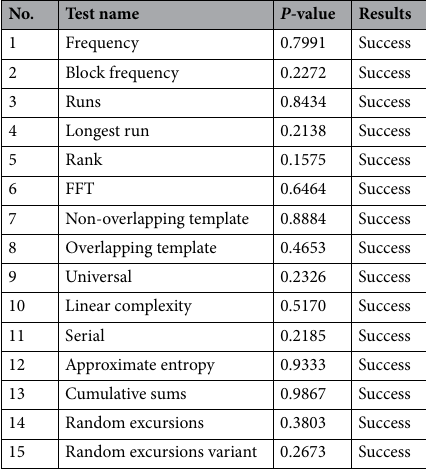
Table 5. NIST test results for chaotic systems.